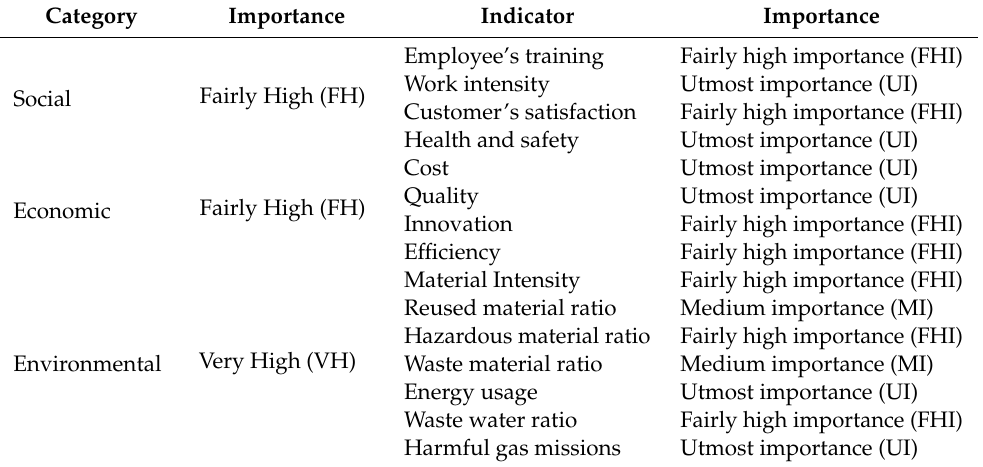
Table 4. The selected sub-criteria and corresponding weights in linguistic form.